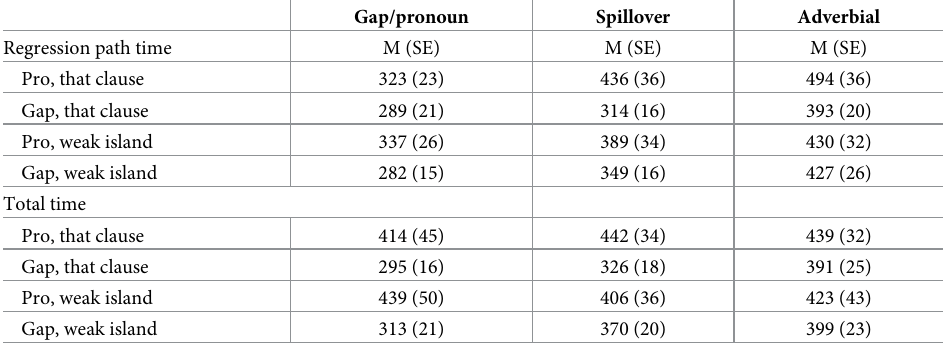
Table 4. Means (and standard errors), in milliseconds, for regression path times and total time for Experiment 2.